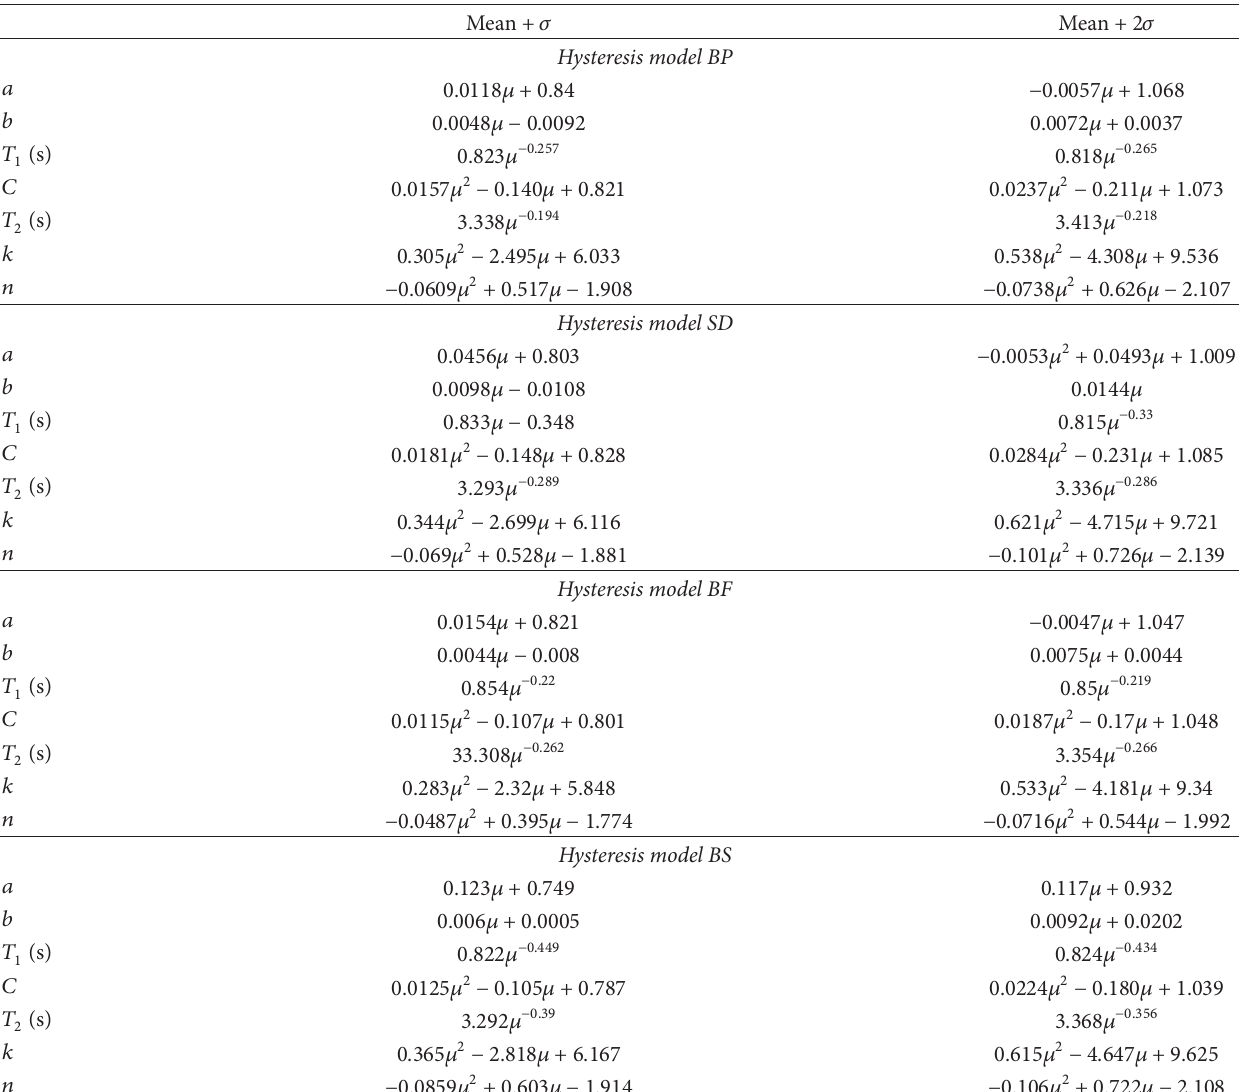
Table 9: Normalized input energy spectral shape parameters (site class E).